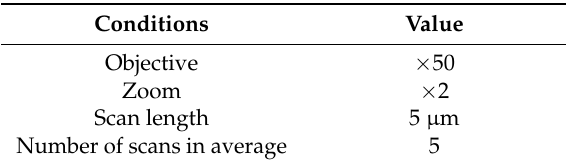
Figure 12. Residual depths of A-plane and C-plane sapphire tested by sequential indentation. Table 2. Parameters of the 3D morphology measurements.